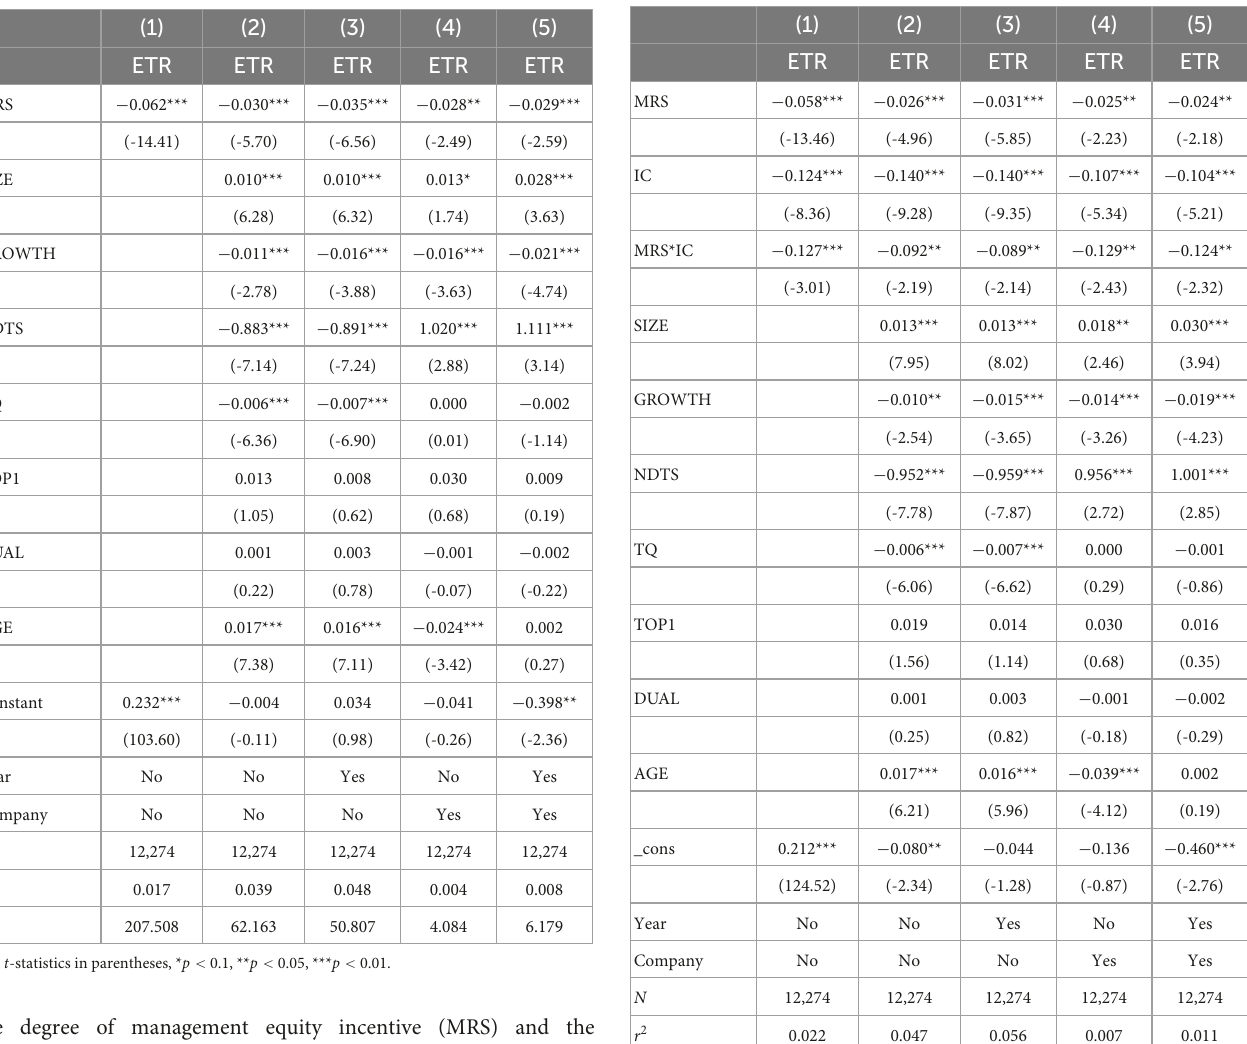
TABLE 7 Robustness test results of the relationship between executive equity incentive and corporate tax avoidance.